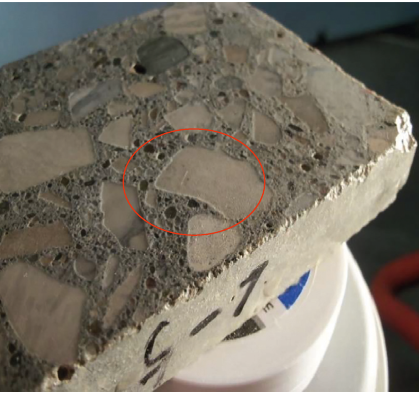
Figure 9: Photo of sample after 56 days in MgCl above aggregate.